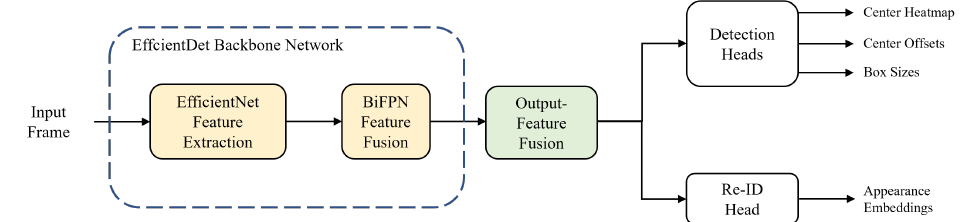
Figure 1. Overall flowchart of our single-shot multi-object tracking (MOT) system.